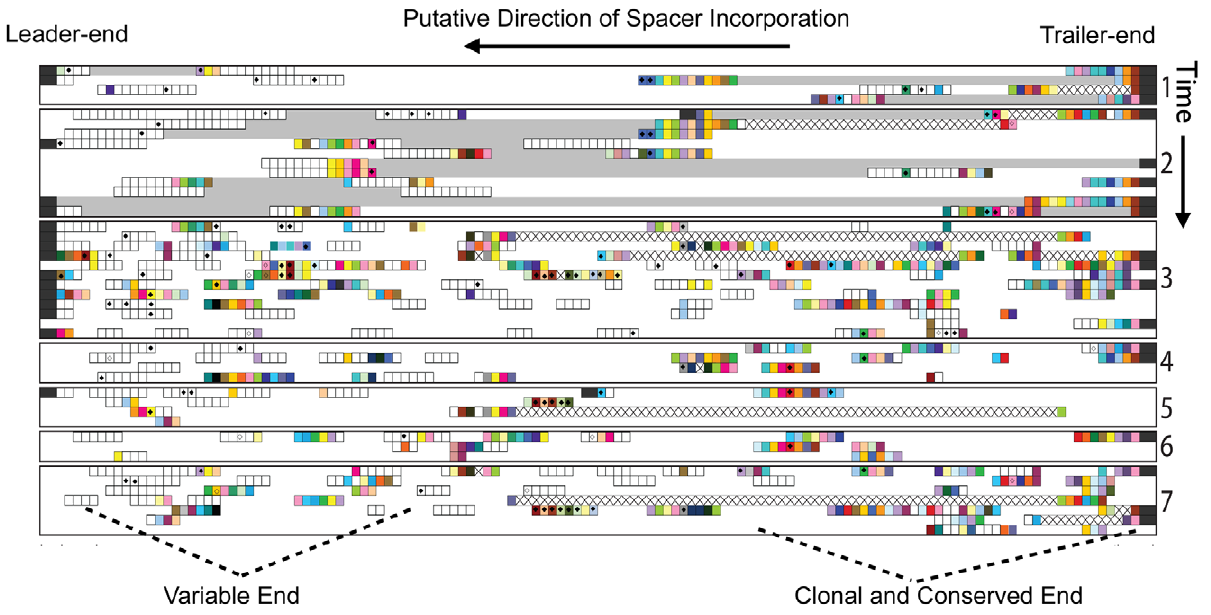
Figure 2. Trailer-end spacers of G-plasma CRISPR locus # 2 match AMDV3b viral regions across the six-year period. Metagenomic reconstructions of the second CRISPR locus of G-plasma at the seven sampled time points. Notably, several trailer-end G-plasma spacers match reconstructed AMDV3b across all time points (filled diamonds).